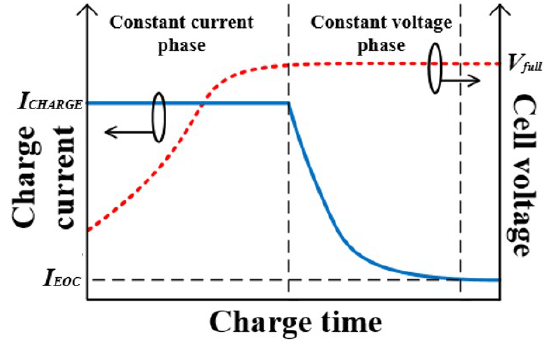
Figure 2 . Constant Current-Constant Voltage charging algorithm.